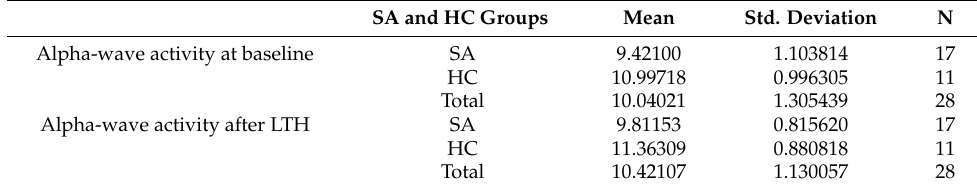
Table 6. Descriptive statics for Alpha-Wave.